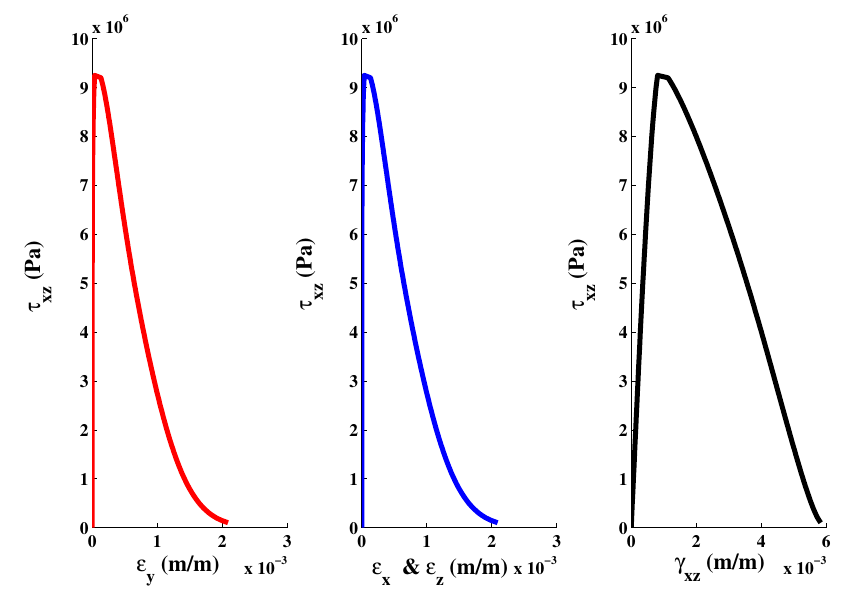
Figure 14. Stress-strains curves in numerical pure shear test.